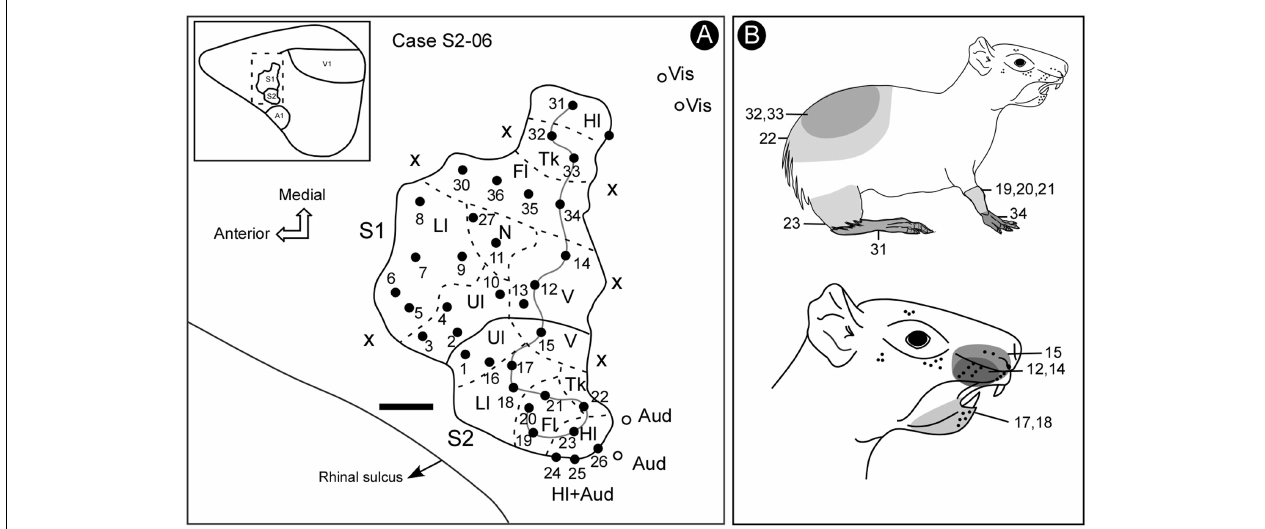
FIGURE 4 | Electrophysiological map (case S2-06) showing the location and organization of S2. Some bimodal responses were identified in a lateral region of S2, across the border with the auditory cortex. In more medial regions, beyond S1, it was possible to identify some visual responses. Notice the reversion in the progression of receptive field locations from S1 to S2 (continuous line) (A) . The shaded areas in the schematic drawing indicate the receptive fields associated with corresponding electrode penetrations in the electrophysiological map, indicated by a continuous line (B) . Scale bar: 1 mm. Fl, forelimb; Hl, hindlimb; Ll, lower lip; N,